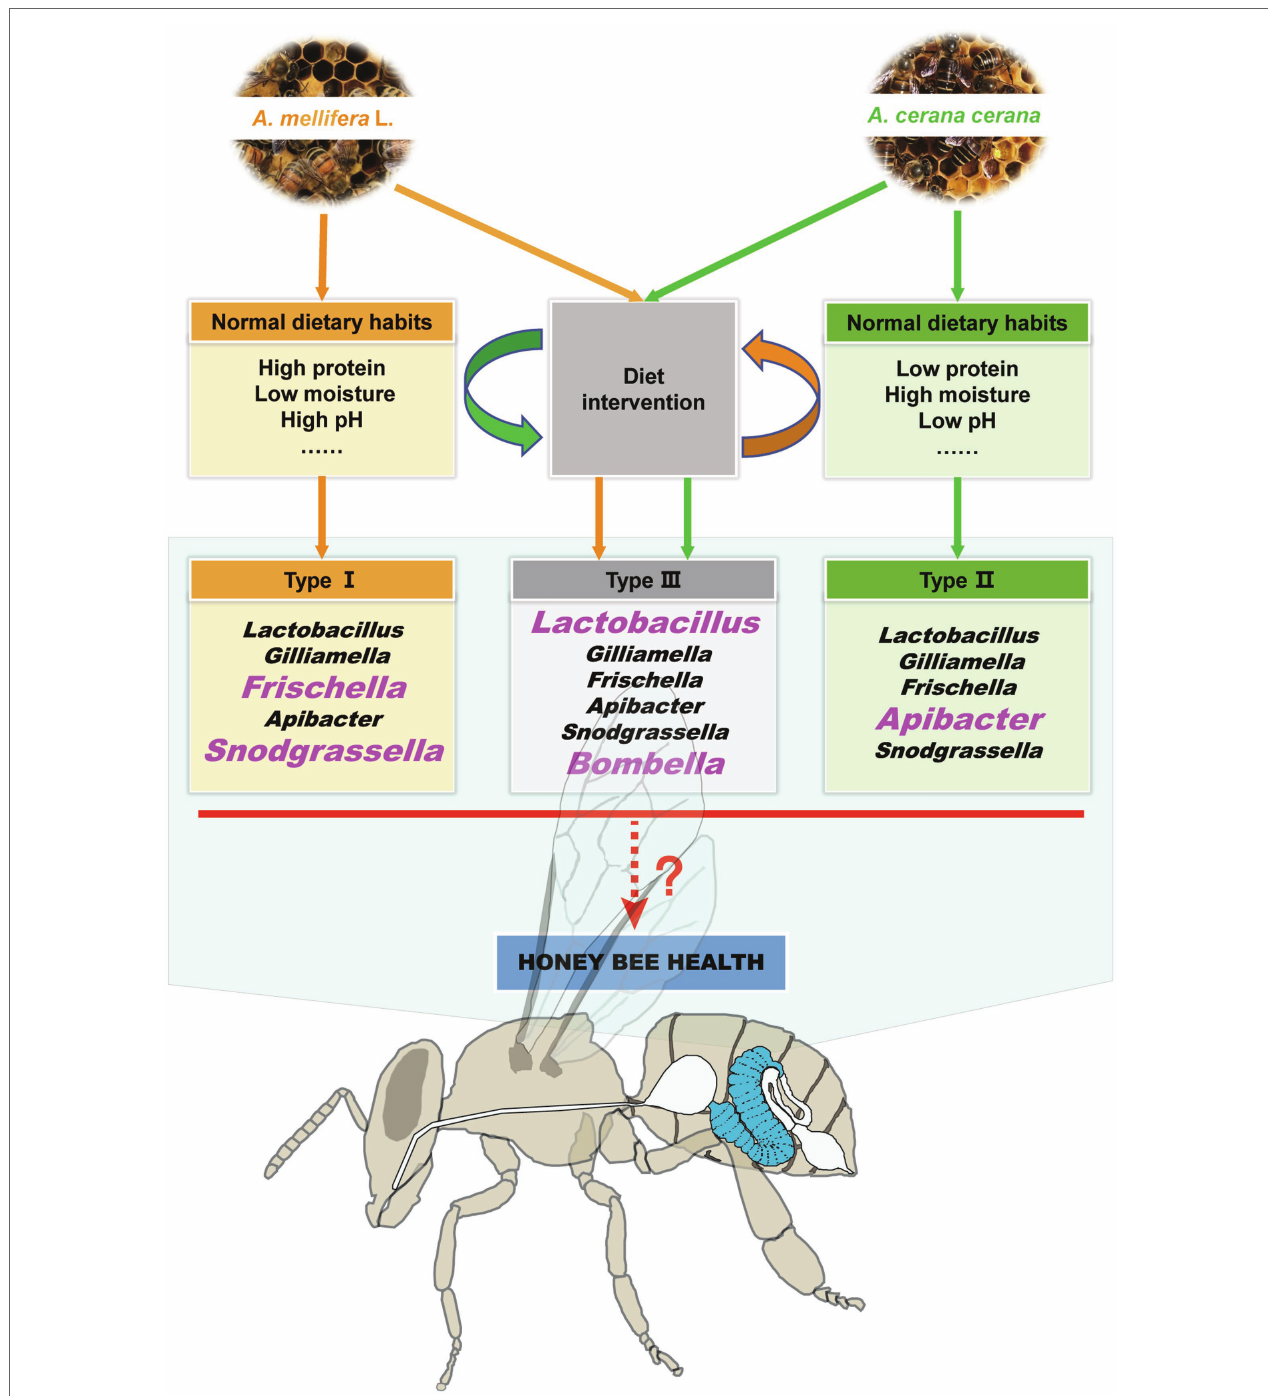
FIGURE 6 | Summary of the effects of dietary habits on shaping the honeybee midgut microbiota and health. The sympatric Apis mellifera and Apis cerana bees have different dietary habits and midgut microbial characteristics. When their dietary habits changed, their unique microbiota signature disappeared, and a negative impact on the growth and development of the two kinds of honeybees was also confirmed. The bacterial genera in large pink font are the characteristic taxa in the corresponding host bee